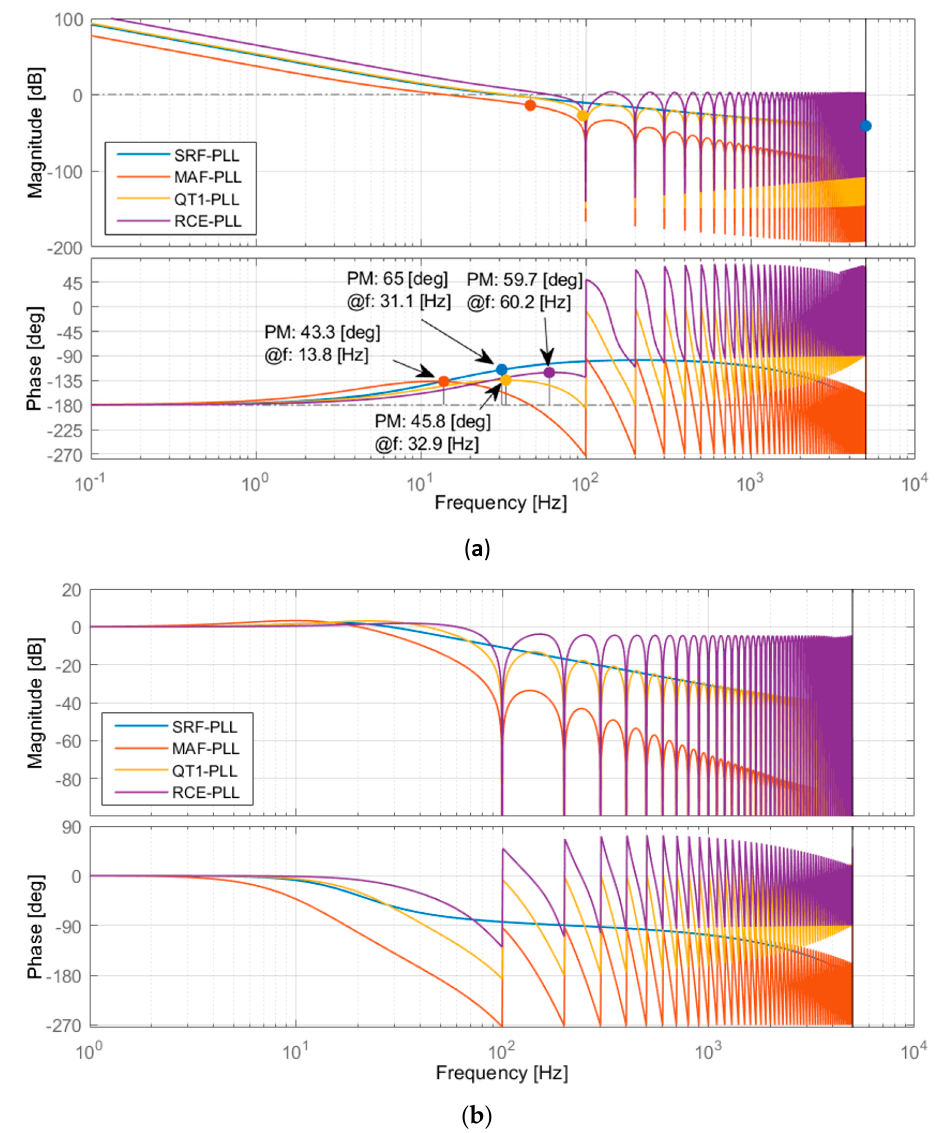
Figure 9. RCE-PLL and other algorithms used for the experimentation (parameter setup as in Table 2). ( a ) Open-loop bode plots; ( b ) closed-loop bode plots.